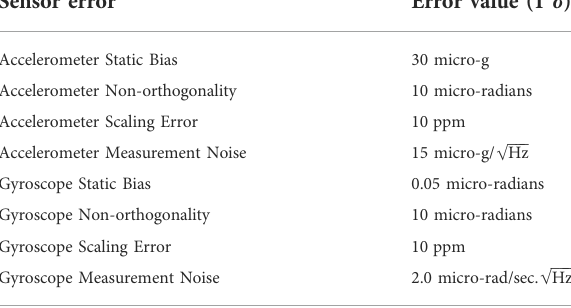
TABLE 1 Measurement errors for an aviation-grade inertial navigation